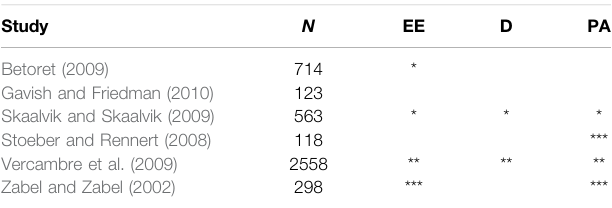
TABLE 4 | Relationships with parents and burnout.